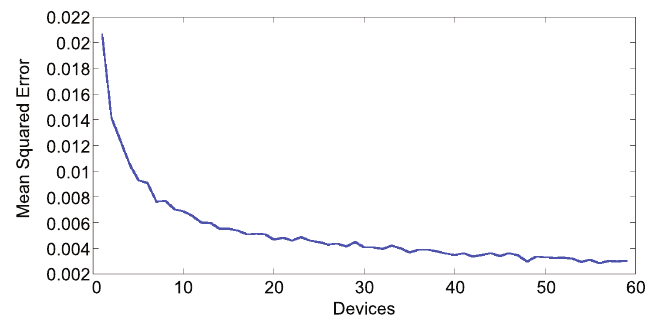
Figure 14. MSE of the traffic occupancy per samples per hour.